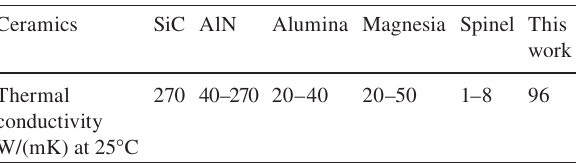
porosity have been investigated and reveal that it has drastic effects on thermal conductivity. In order to control porosity and density, coating the AlN starting powder with a thin layer of magnesium may prove benefi cial. Table 4 Thermal conductivity of some ceramics used for electrical substrate [1, 12, 26]